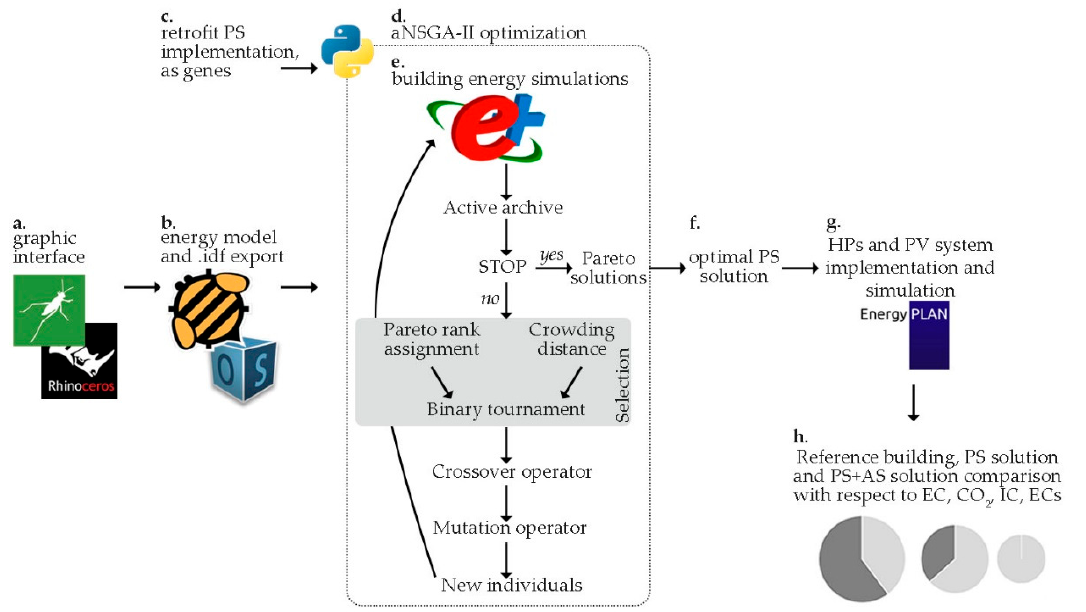
Figure 1. Methodological workflow with steps a-h. Legend: PS—passive strategies; AS—active strategies; HPs—heat pumps; PV—photovoltaic; EC—energy consumption; CO 2 —CO 2 emissions; IC—investment costs; ECs—energy costs.